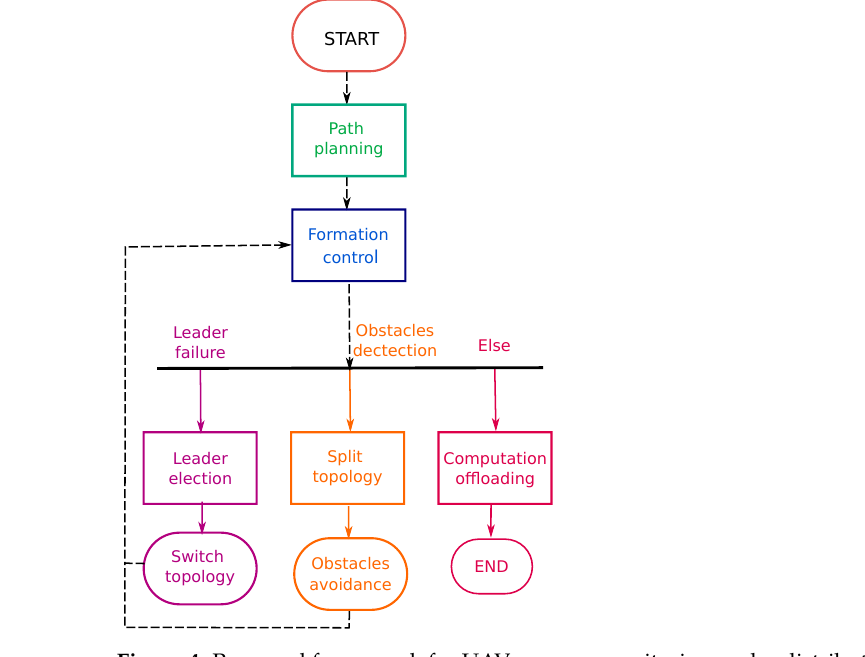
Figure 4. Proposed framework for UAVs swarm monitoring under distributed L-F